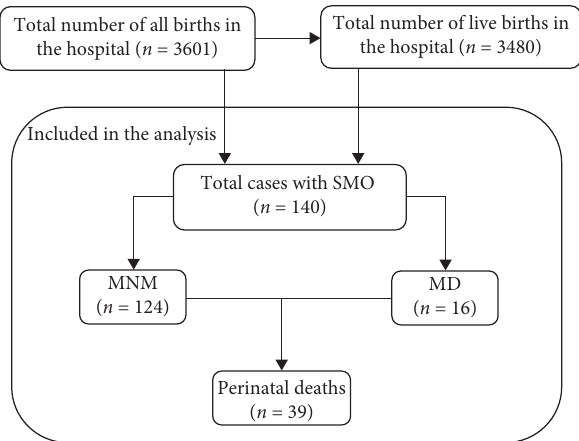
Figure 1: Flowchart of sampling units included in this